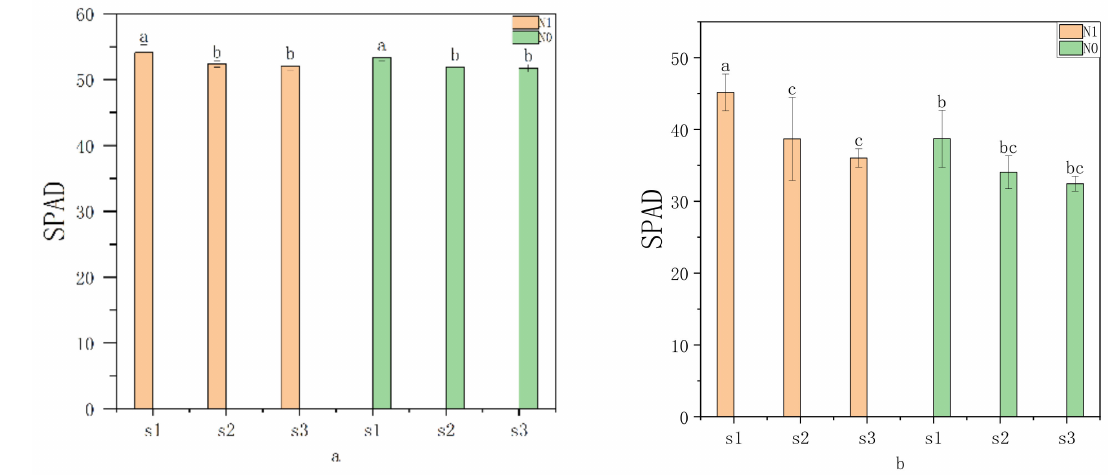
Figure 4. Effects of different nitrogen (N) and salt (S) treatments on SPAD at the stage of V12 ( a ) and VT ( b ). The ANOVE results are given for each S and N. Values are means ± SD per treatment. Different letters indicate statistically significant ( p < 0.05) differences between the treatments using a Tukey post hoc test. N1 is nitrogen application, and N0 is no nitrogen application. S1, S2 and S3 are the soil salinity concentrations of 0%, 0.1% and 0.25%,